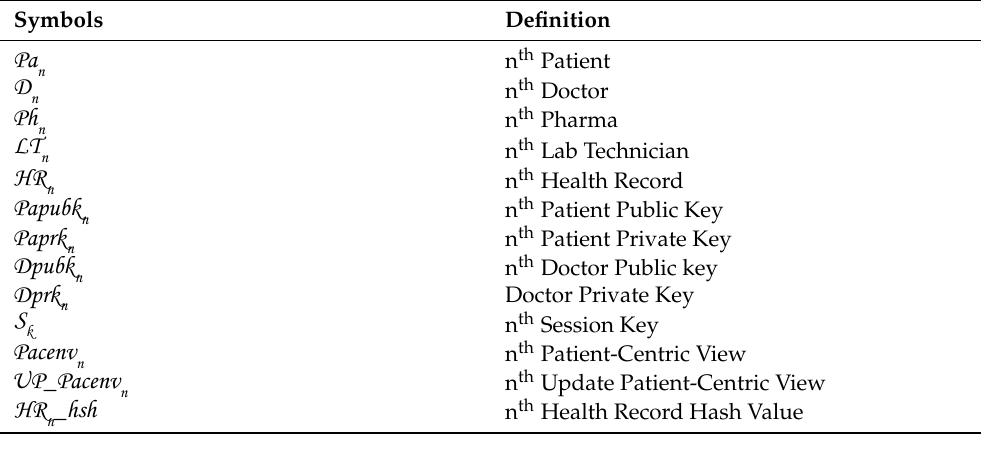
Table 5. Symbols in the algorithm functions.